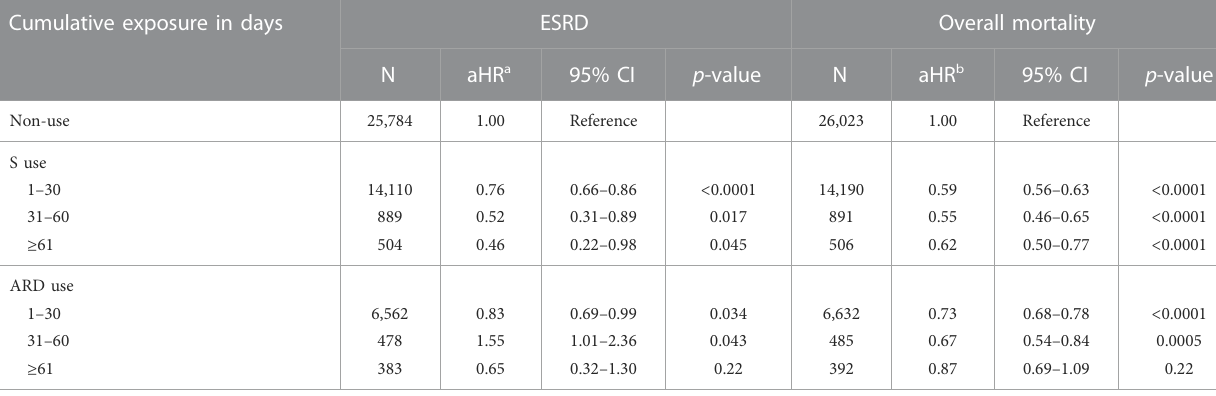
TABLE 4 Cumulative exposure duration of S and ARD use and the risk of the study outcomes of at least > 1 year of follow-up.